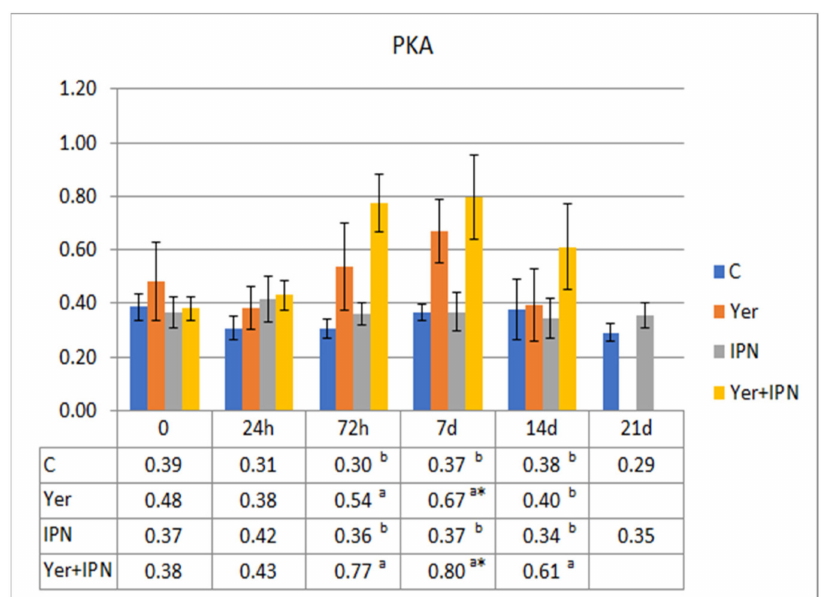
Figure 16. Mean values and standard deviation of phagocyte-killing activity over the course of the second experimental infection. *—statistically significant differences compared to the day 0 values within a given group ( p ≤ 0.05); a, b —statistically significant differences between the groups on a given sampling day ( p ≤